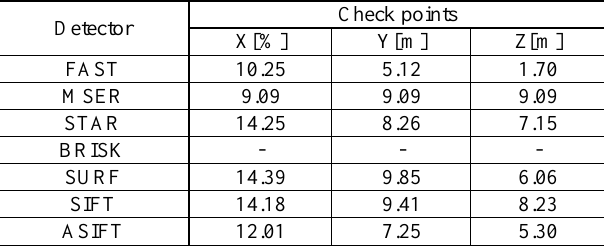
Table 4 Percentage of points with error not exceeding 2RMSE values (control and check points).